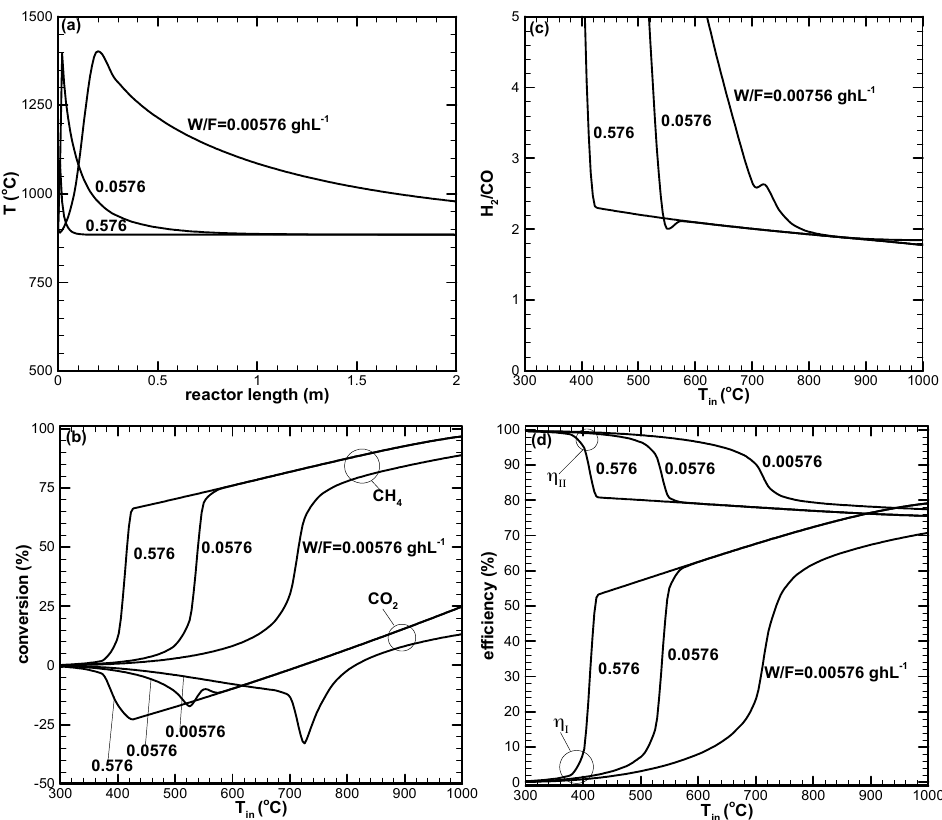
Figure 5. Effect of catalyst weight/volume flow rate (W/F) ratios on the TR process. Catalyst weight is varied from 0.025 to 2.5 g while the other parameters were kept unchanged, as listed in Table 1. ( a ) Temperature variation along reactor with T in = 900 °C; ( b ) CH 4 and CO 2 conversions; ( c ) H 2 /CO ratio; and ( d ) first- and second-law efficiencies.